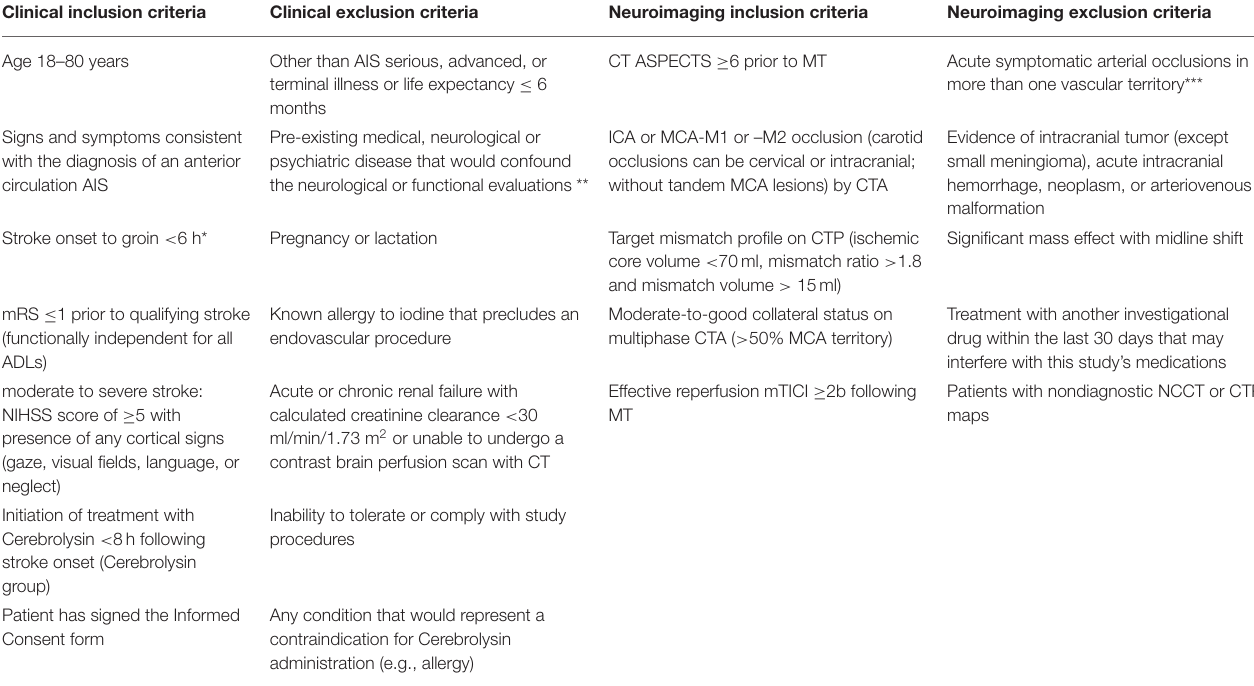
TABLE 2 | Study eligibility criteria. Clinical inclusion